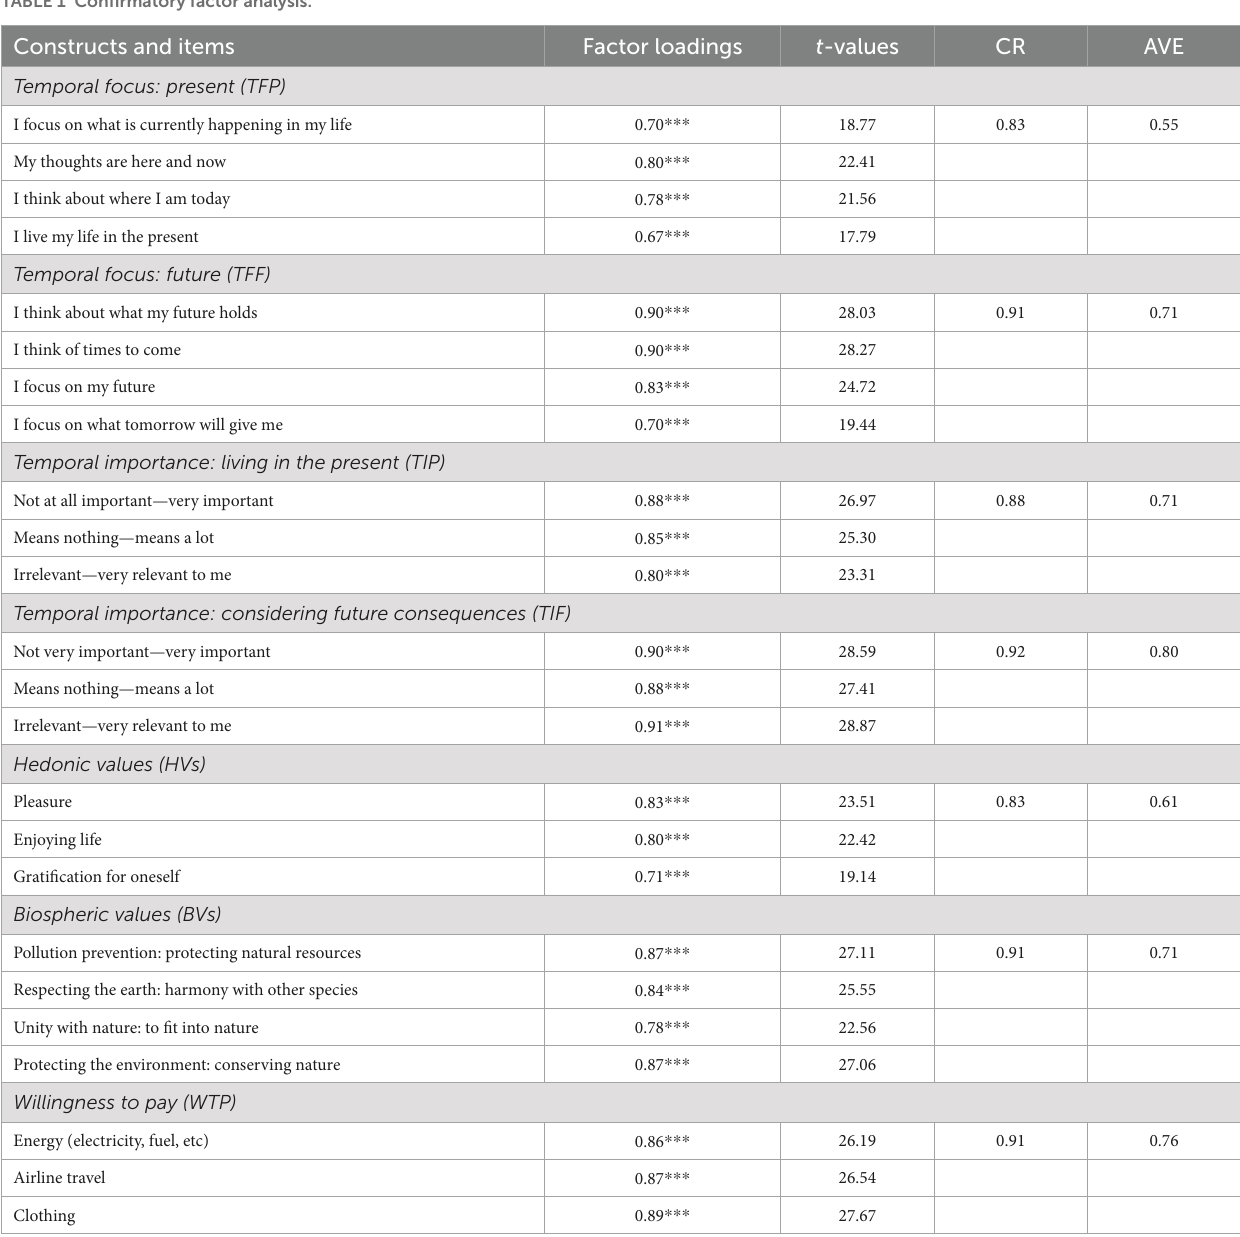
TABLE 1 Confirmatory factor